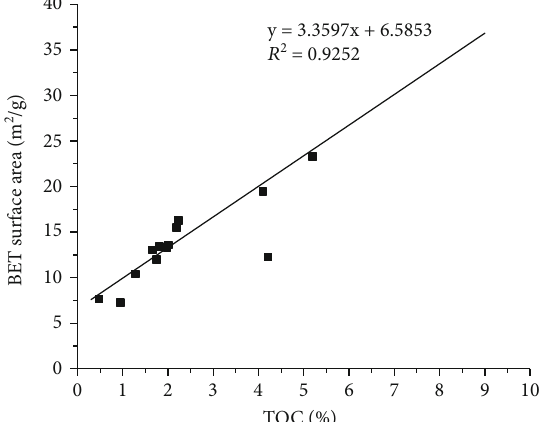
Figure 10: Relationship between the TOC content and BET surface